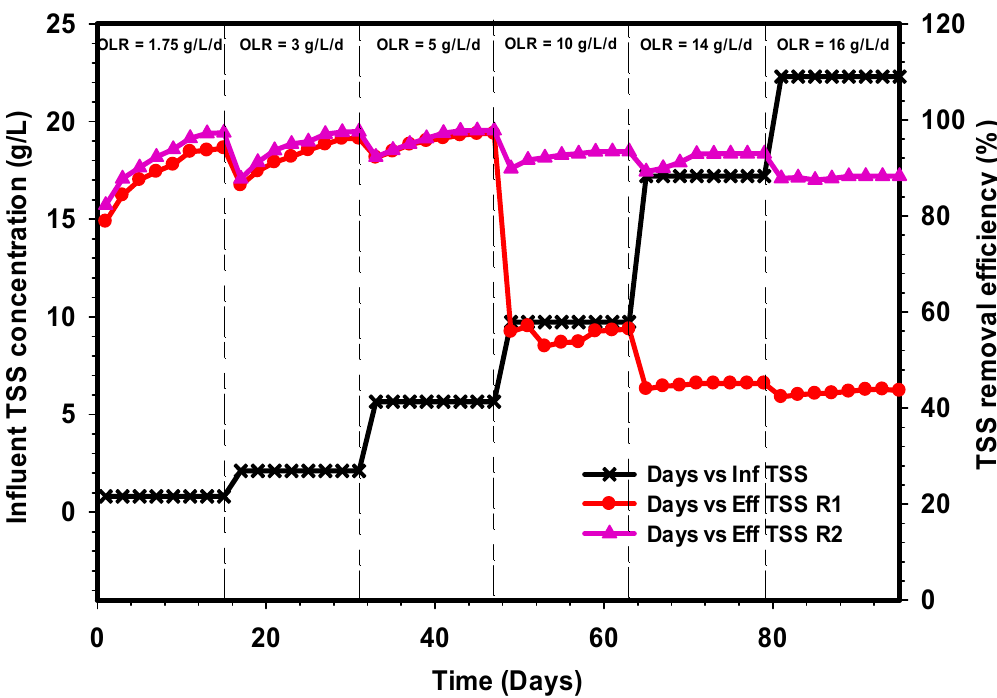
Figure 4. Comparison of total suspended solids removal efficiencies of R1 and R2.